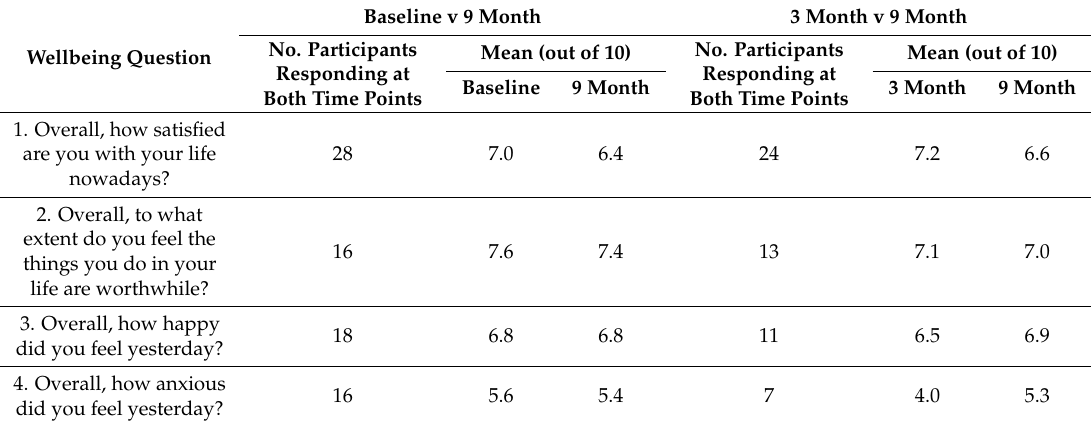
Table 3. Mean general wellbeing scores for intervention participants at baseline, 3 months and 9 months. Baseline v 9 Month 3 Month v 9 Month No. Participants Mean (out of 10) Mean (out of 10) No. Participants Wellbeing Question Responding at Responding at Baseline 9 Month 3 Both Time Points Both Time Points